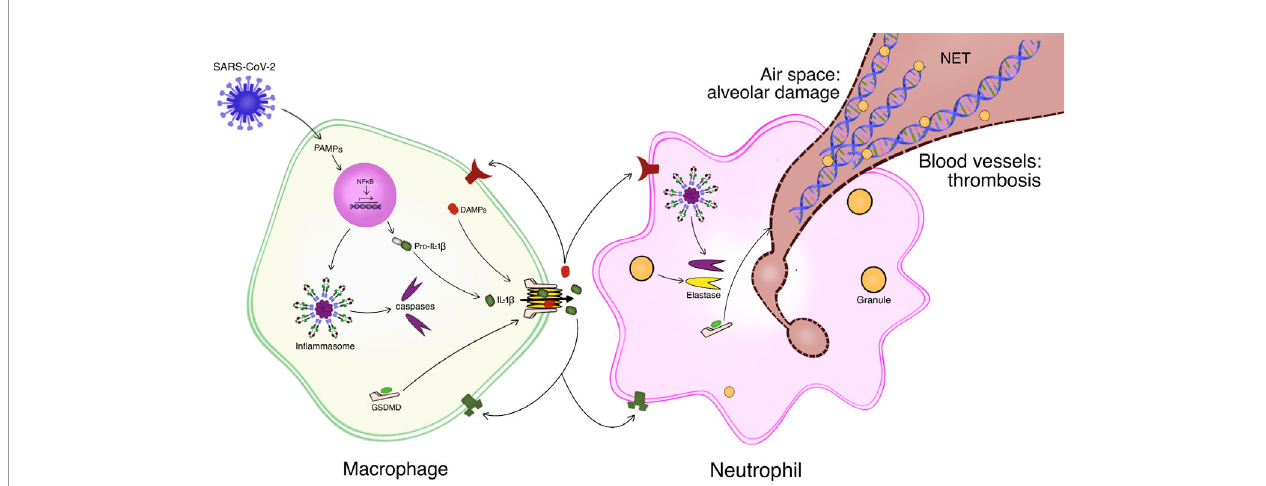
FIGURE 1 | Schematic of lung-centric in fl ammation and immunothrombosis in response to SARS-CoV-2 infection. Resident alveolar macrophages mount an in fl ammatory response to infection of the lungs by SARS-CoV-2. Macrophages detect viral material e.g., pathogen-associated molecular patterns (PAMPs). PAMPs activate the NF k B pathway which generates pro-IL-1 b and components of the in fl ammasome. Assembly and functional activation of the in fl ammasome results in caspase-mediated cleavage of pro-IL-1 b to the mature IL-1 b . Caspase cleavage of gasdermin D (GSDMD) allows it to enter the plasma membrane and oligomerize, forming pores. IL-1 b as well as other in fl ammatory mediators, such as damage-associated molecular patterns (DAMPs) exit the macrophage through the GSDMD pores. The in fl ammatory response is ampli fi ed by feed-forward mechanisms and recruitment of additional leukocytes, e.g., neutrophils. Activated neutrophils can extrude neutrophil extracellular traps (NETs), a meshwork of decondensed DNA decorated with granule-derived proteases and antimicrobials. In fl ammasome-derived caspase as well as granule-derived elastase activate GSDMD to form the pores for NET release. NETs formed in the alveolar space can induce lung injury while NETs generated within blood vessels sequester platelets and coagulation factors to promote thrombogenesis. Modi fi ed from (Tall and Westerterp,